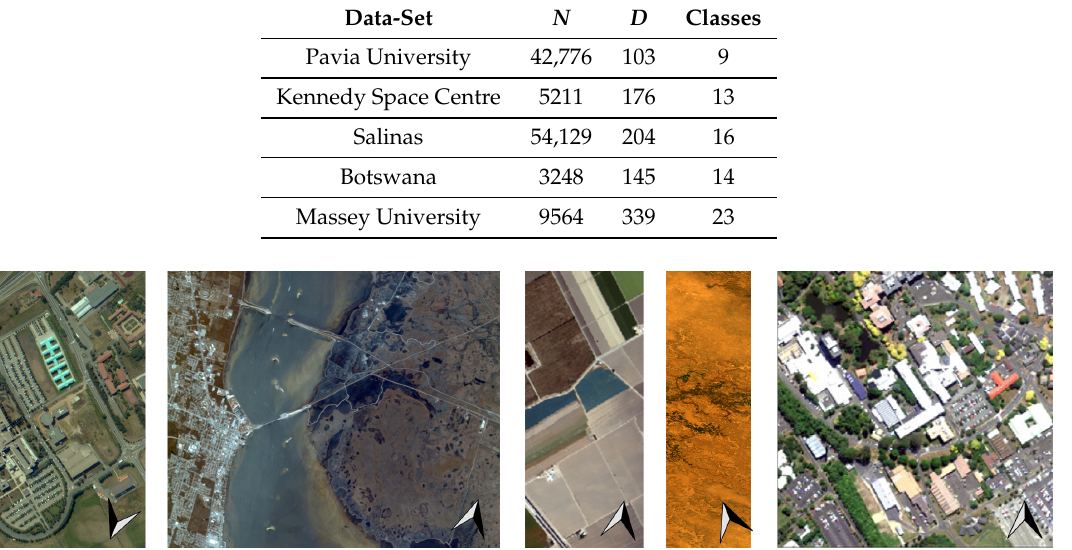
Table 3. Description of data-sets used: number of labelled pixels N , dimensionality D and number of classes. Data-Set